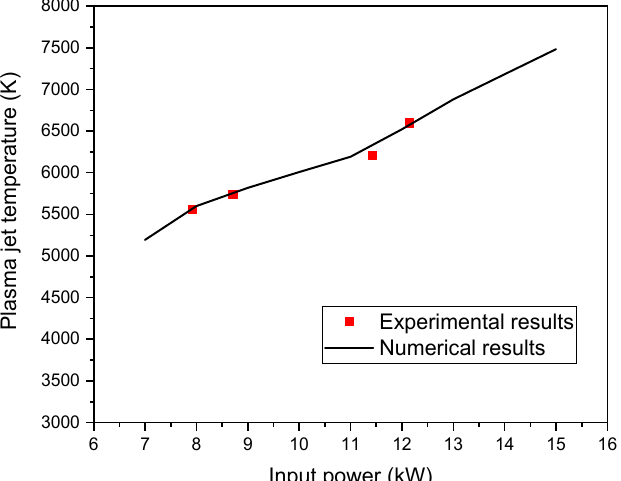
Figure 7. Variation of calculated and experimental input plasma jet temperature with input power.